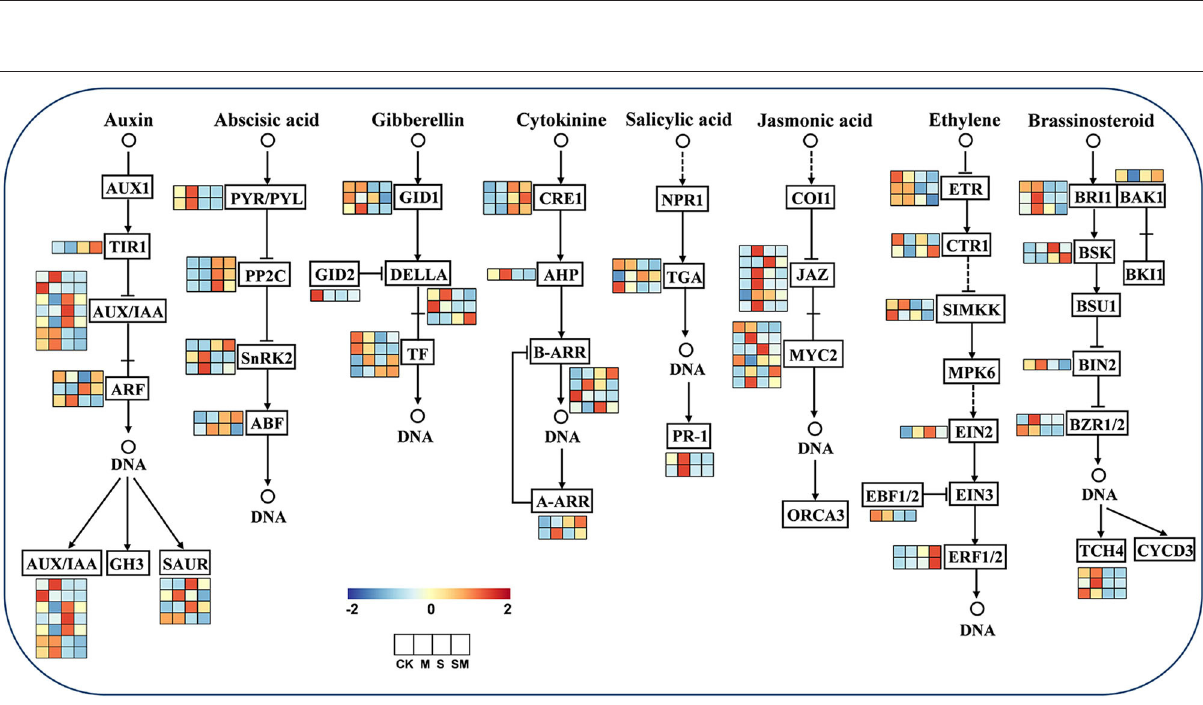
Frontiers in Plant Science |